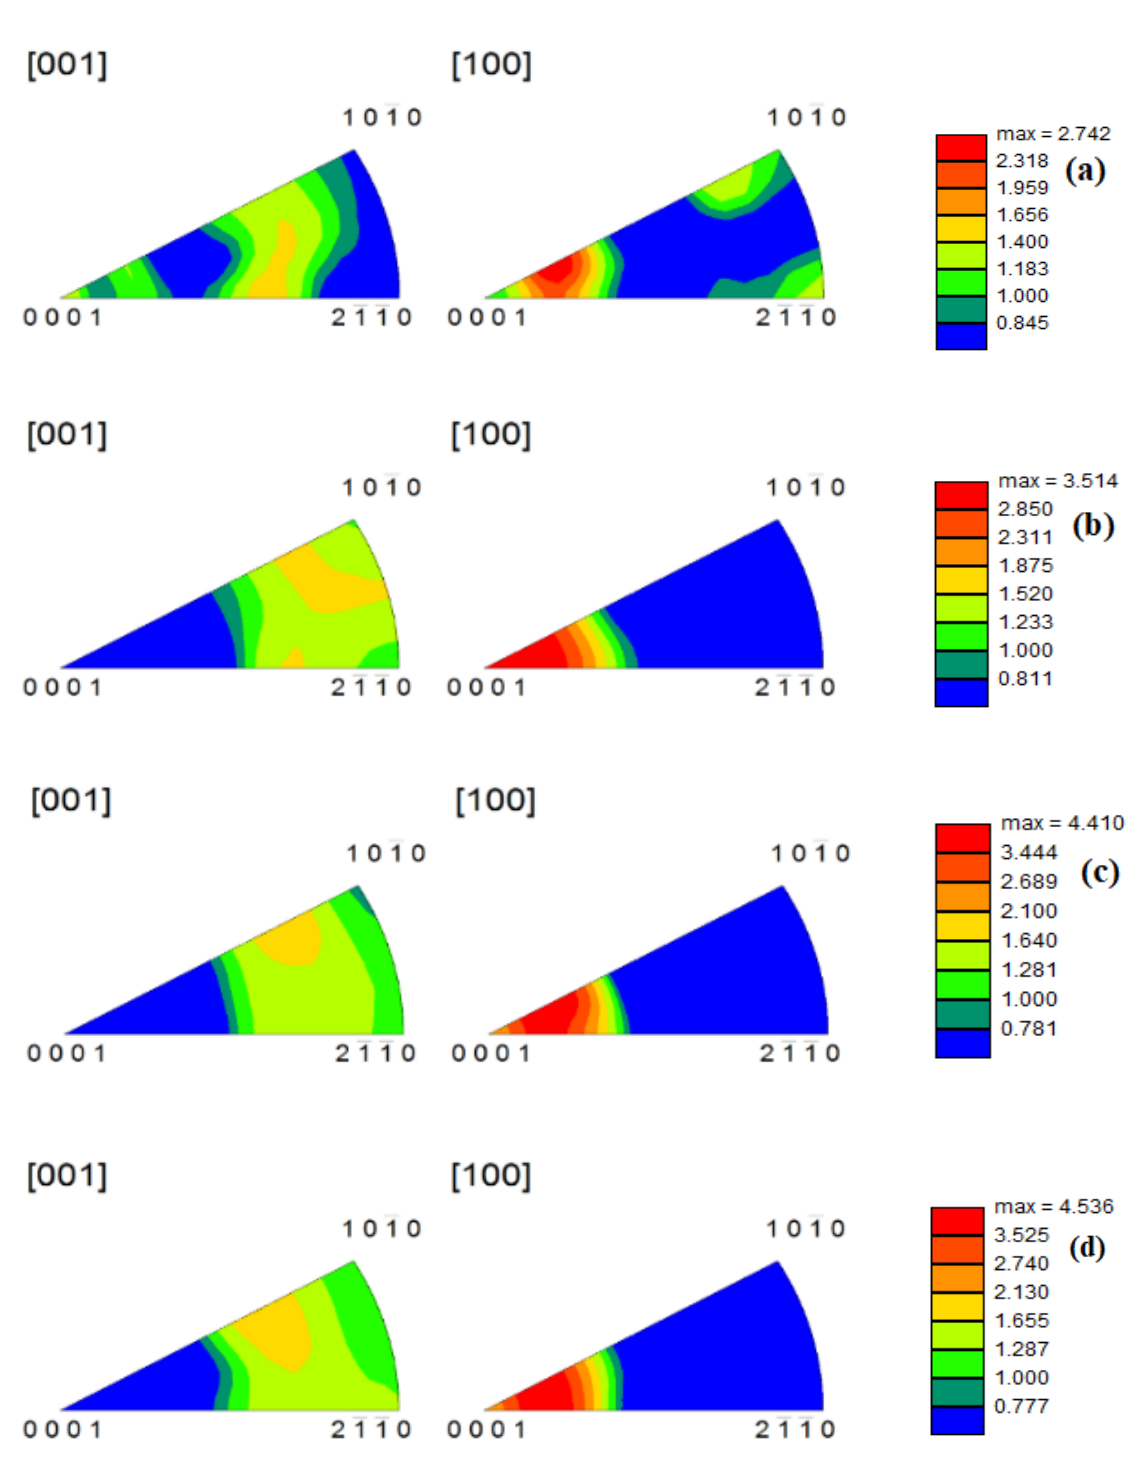
Figure 11. Anti-pole diagrams of the alloy during hot compression at 733 K ( a ) 0.001 s −1 ; ( b ) 0.01 s −1 ; ( c ) 0.1 s −1 ; ( d ) 1 s −1 .